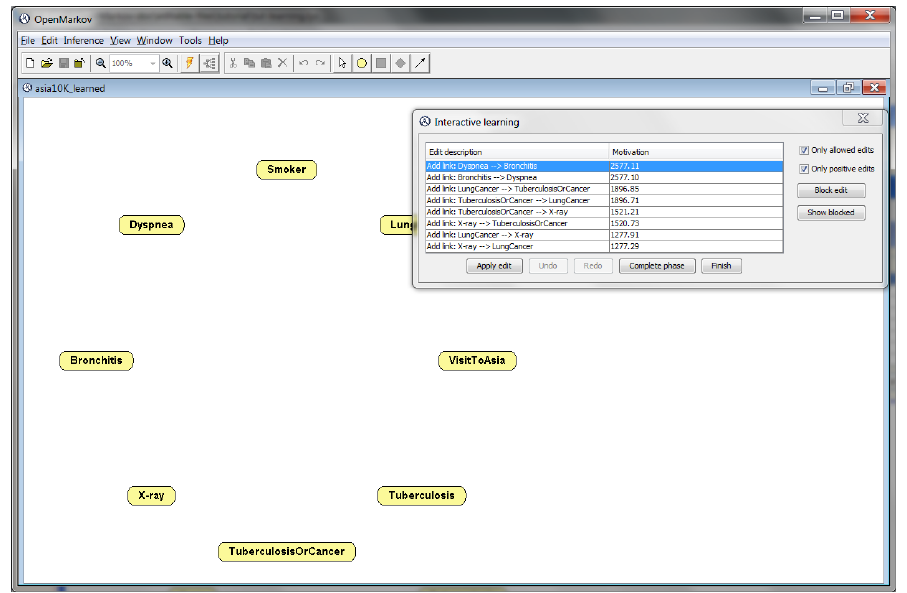
Figure 4. Initial state of the interactive search-and-score algorithm when applied to a dataset gener- ated from the Bayesian network Asia . The “Motivation” column shows the score of each edit for the metric selected.